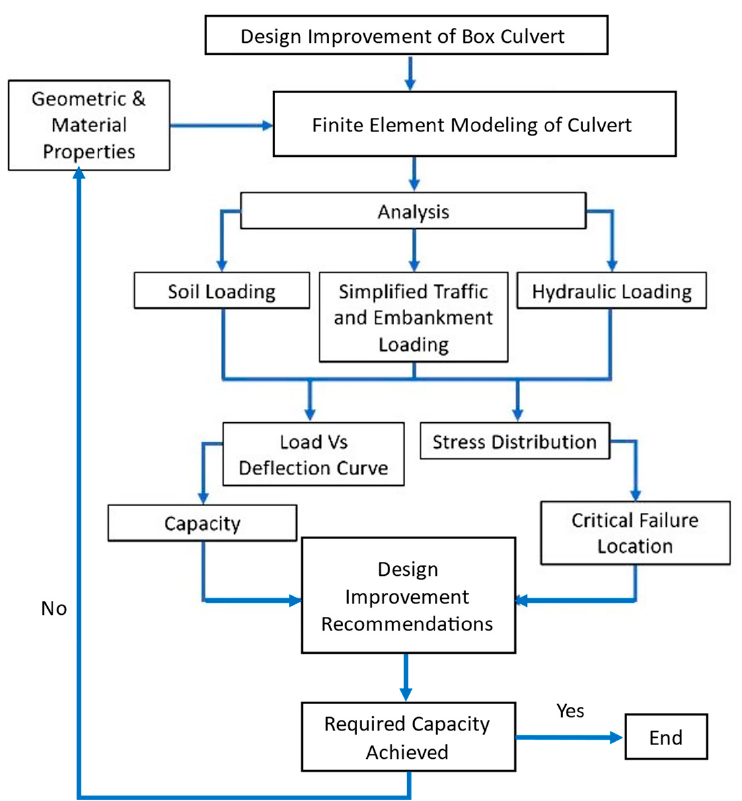
Figure 1. The methodological framework adopted in the current research study.